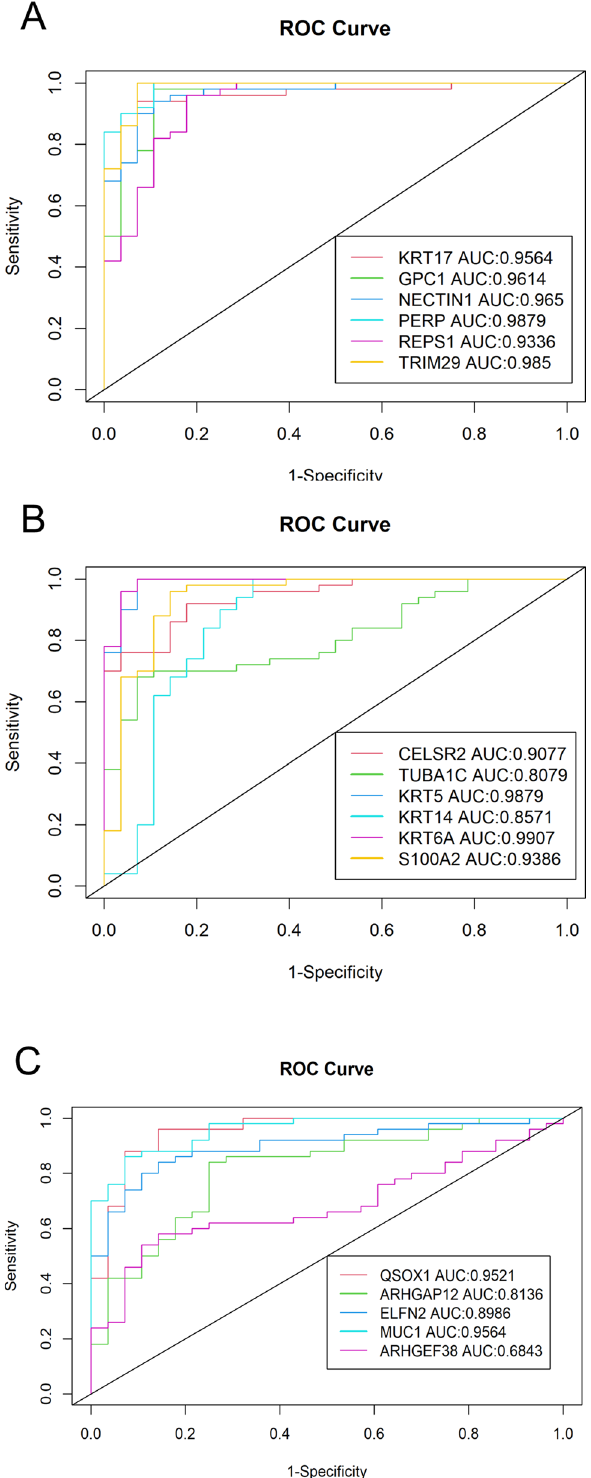
Figure 6. GSE28582 microarray dataset ROC and AUC validation of the 17 candidate biomarkers 87 . ( A , B ) The upregulated genes, and ( C ) shows the downregulated genes. The x-axis represents sensitivity, or true positive rate (TPR). The y-axis is 1 − Specificity, or false positive rate (FPR). Higher AUC indicates higher discriminating potential for the